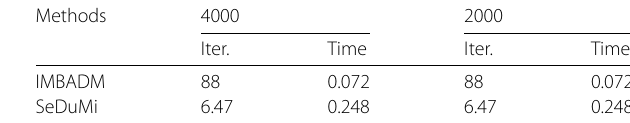
Table 1 The test results for the multiple force-optimization problems of Example 5.1